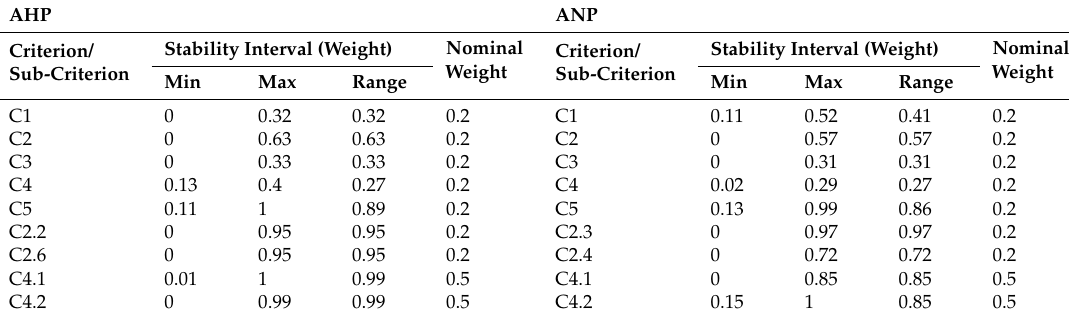
Table 10. Stability intervals of